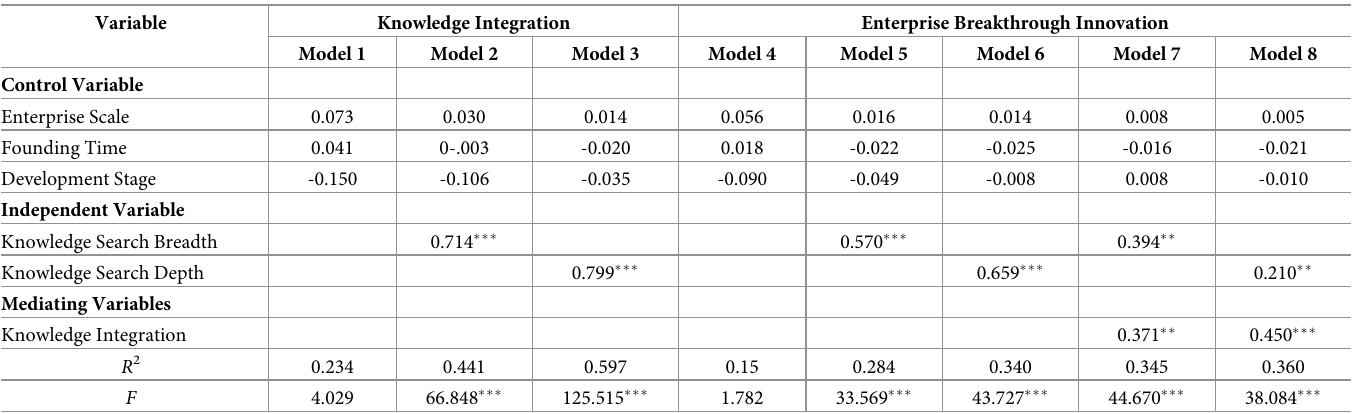
Table 6. Test of main effect and mediating